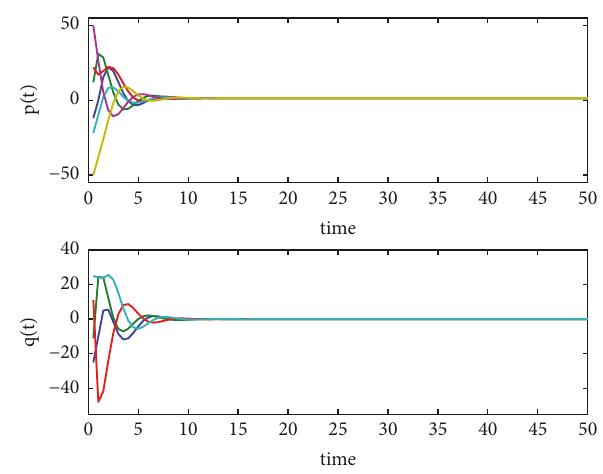
Figure 4: Agents’ state trajectories over network G 2